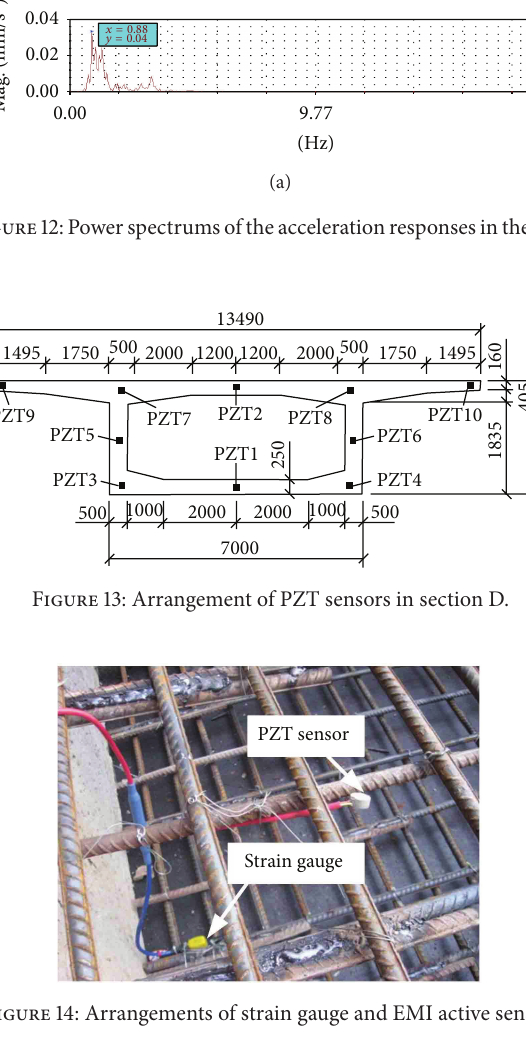
Figure 16: Field